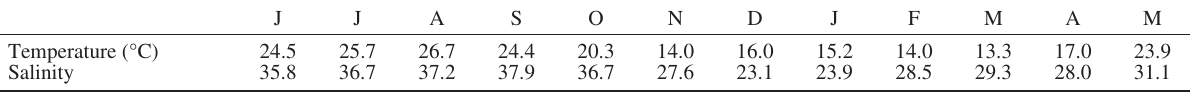
Table 1. – Monthly seawater temperature and salinity values recorded in Bizerta Channel during the study period (June 2009 - May 2010). J